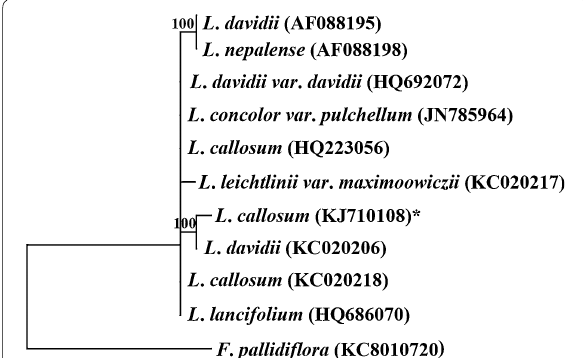
Fig. 5 The phylogenetic tree was generated from parsimony analyses using the nuclear internal transcribed spacer (ITS). The tree is rooted with Fritillaria pallidiflora , and the values above branches indi- cate node support (bootstrap percentages above the sequence of L . callosum in this